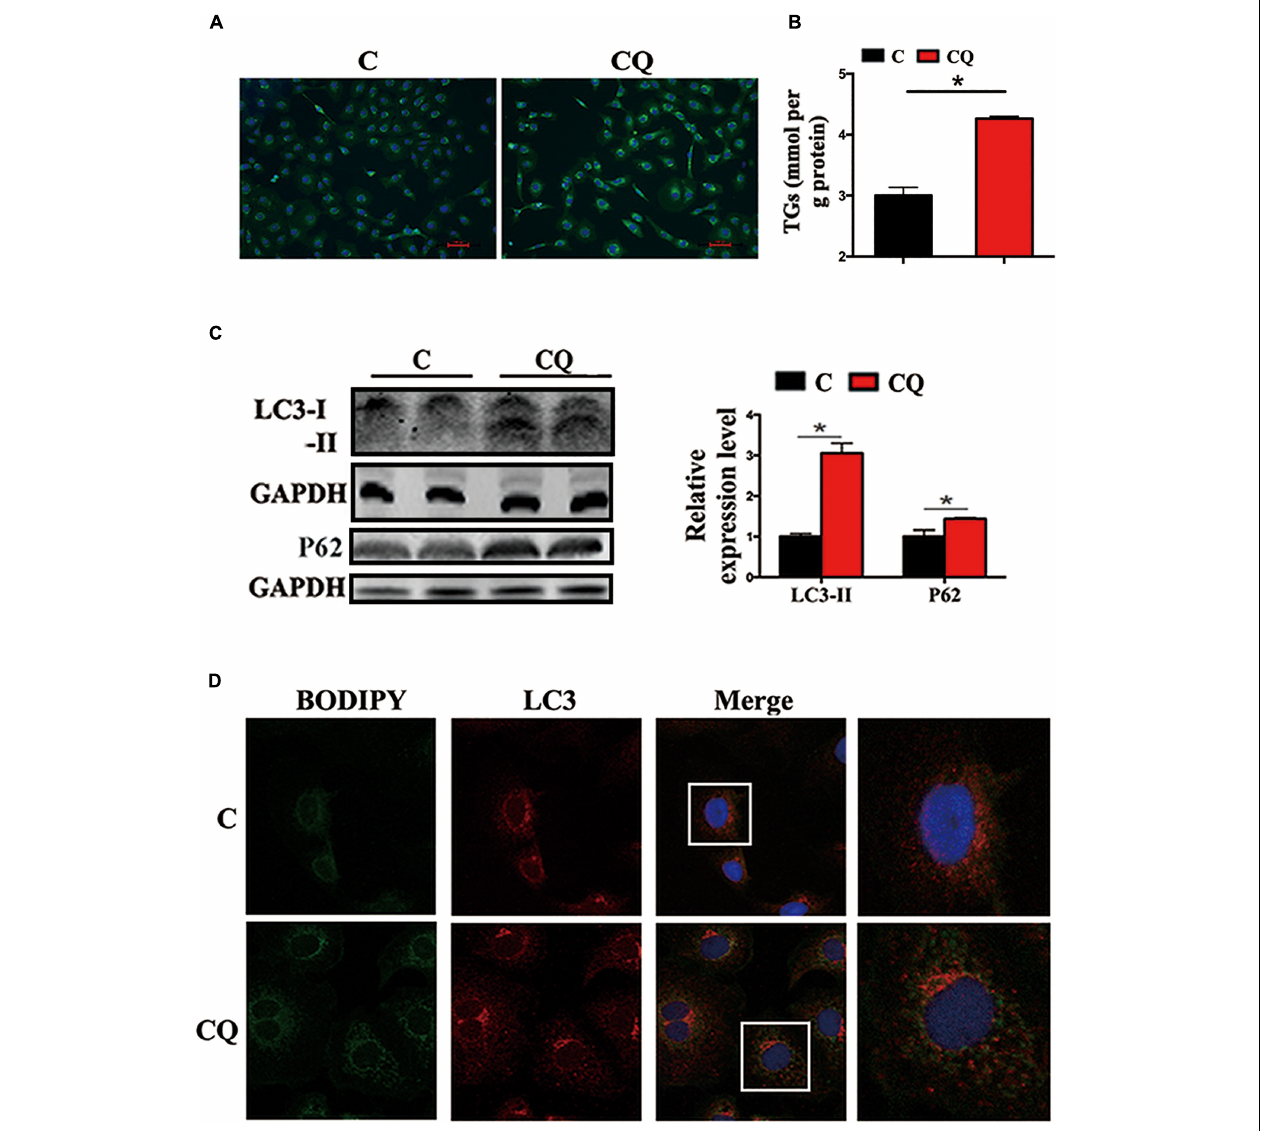
FIGURE 3 | Inhibited lipophagy causes accumulation of lipid droplets in ZFL cell line. (A,B) Lipid droplets (LDs) stained with BODIPY 493/503 and TG contents in the ZFL cells. (C) Immunoblot and densitometric analysis of LC3 and p62 in the ZFL cells. ( ∗ P < 0.05, n = 6). Error bars, SEM. (D) Co-localization of BODIPY 493/503 (green) with LC3 (red) in treated samples with